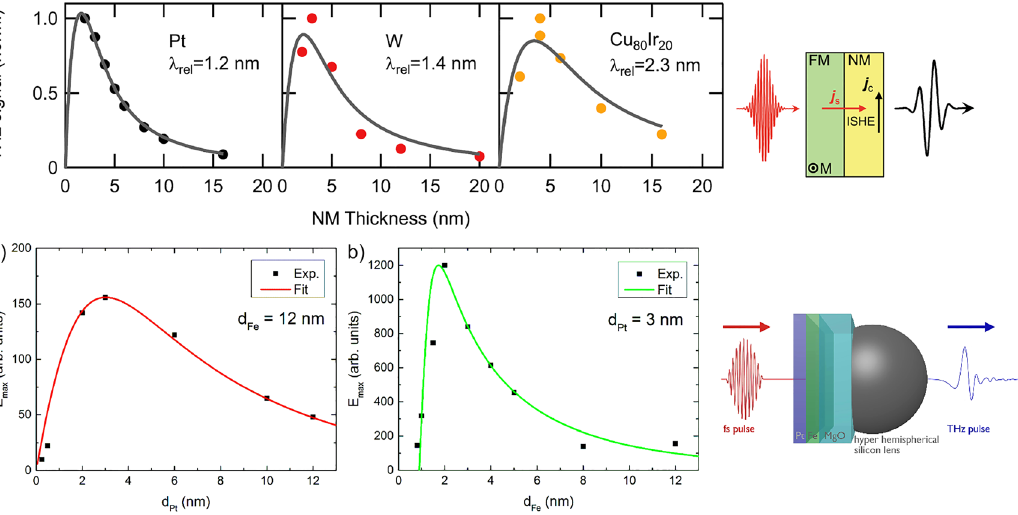
Figure5: (Upperpanel)NonmagneticlayerthicknessdependenceofTHzemissionfordifferentNMlayerslikePt,W,CuIrinCoFeB/NMbilayers [21], and the geometrical arrangement of the experiment. Reproduced under the terms of a Creative Commons Attribution 3.0 Licence [21], 2018 IOP Publishing